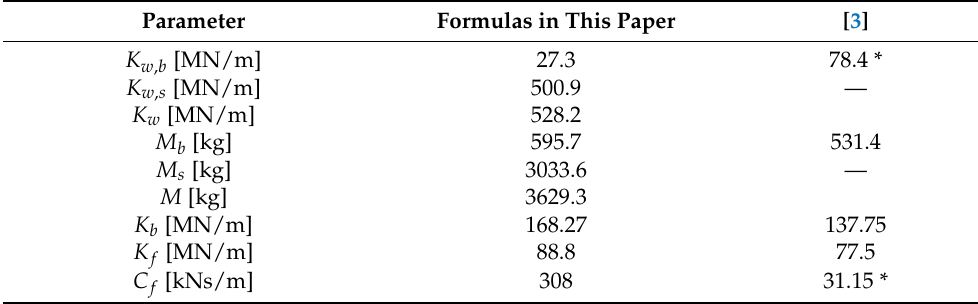
Table 8. Model data summary.